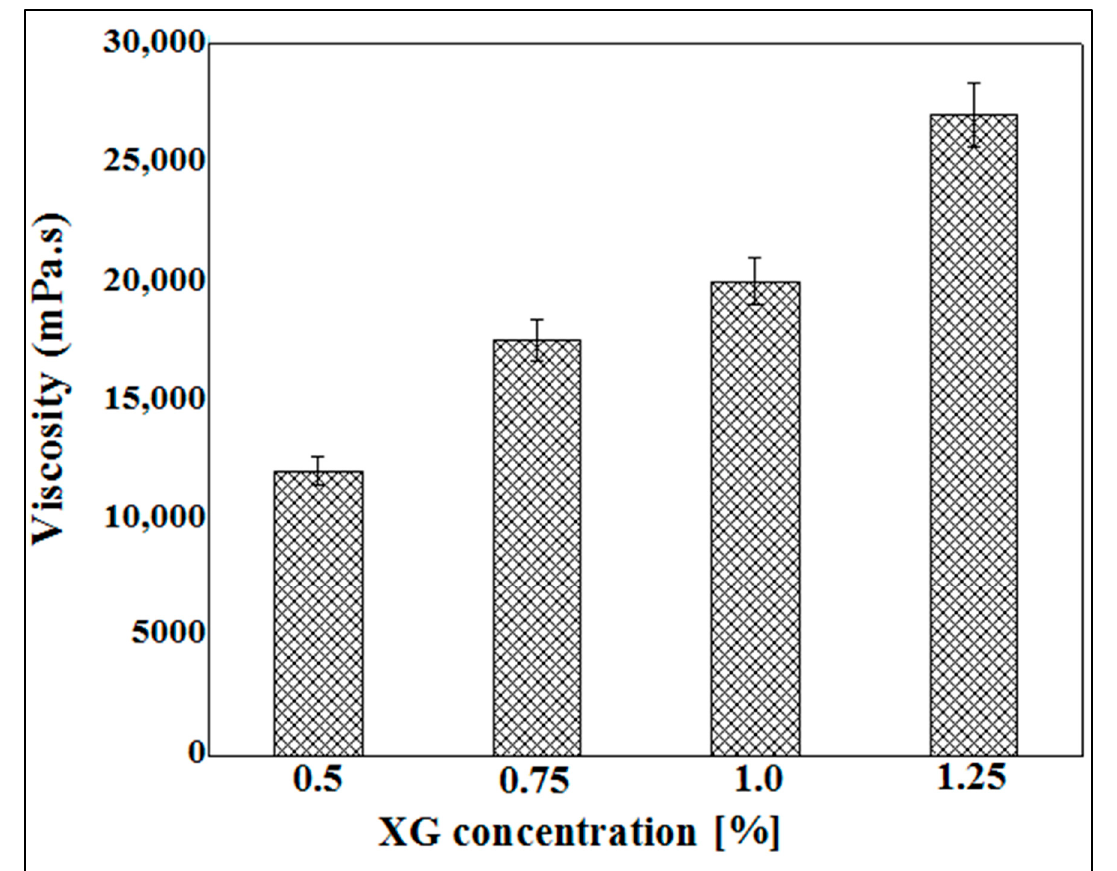
Figure 3. Viscosity measurement as a function of XG concentration varying between 0.5% and 1.25%.